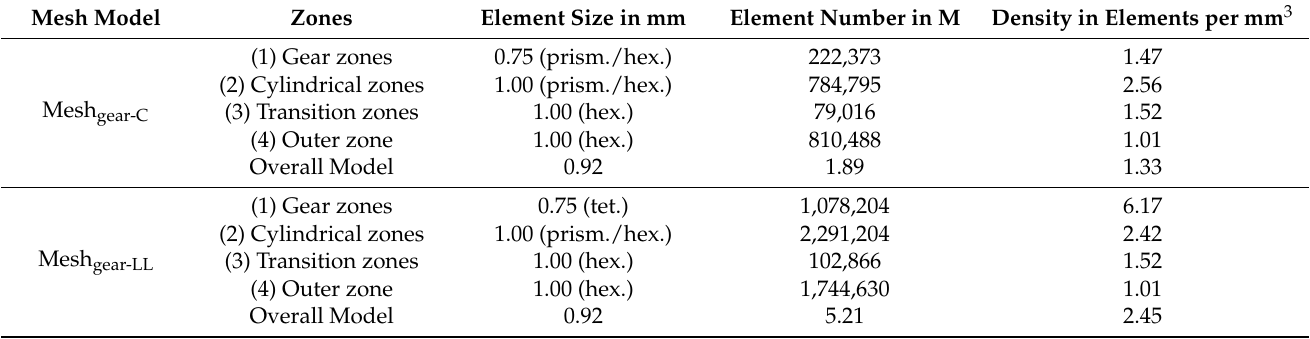
Table 3. Properties of the considered mesh models Mesh gear-C and Mesh gear-LL (prism.: prismatic; hex.: hexahedral; tet.: tetrahedral).